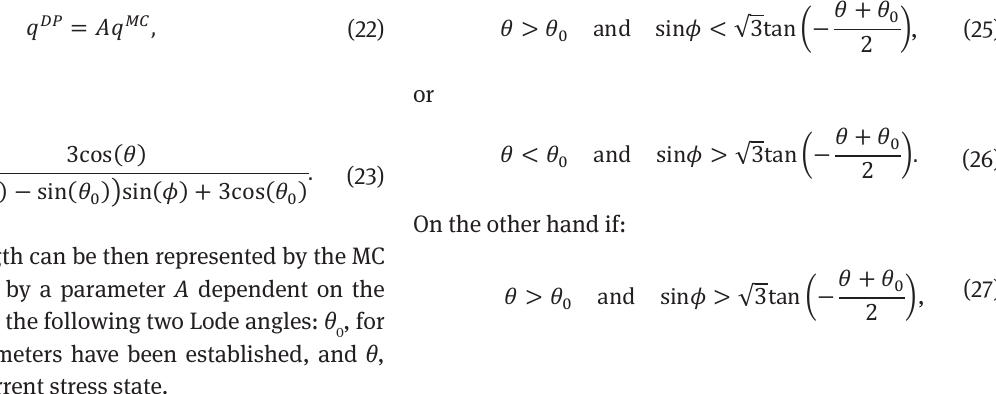
Figure 1: Variability of Drucker-Prager shear strength vs. Mohr-Coulomb shear strength with respect to Lode angles θ angle ϕ . The q DP = q MC line represents the equivalent friction angles for the case of the DP